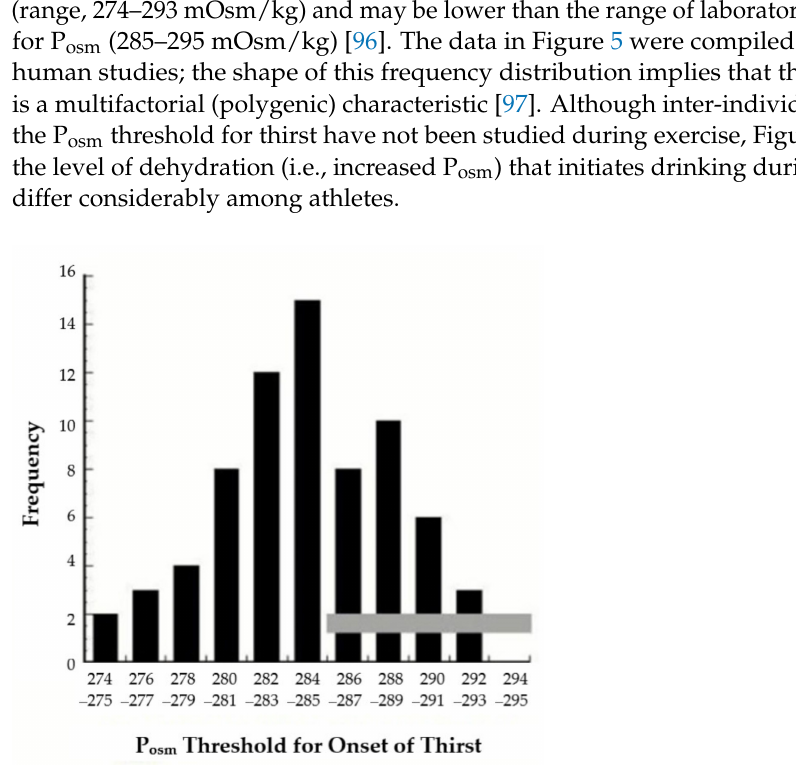
Figure 5. Frequency distribution of the plasma osmolality (P osm ) threshold for the onset of thirst. The horizontal gray bar delineates the laboratory reference range of P osm values (285–295 mOsm/kg) for healthy adults. Reprinted under the terms and conditions of the Creative Commons Attribu- tion (CC BY) license (http://creativecommons.org/licenses/by/4.0/) accessed on 2 March 2021. Modified from